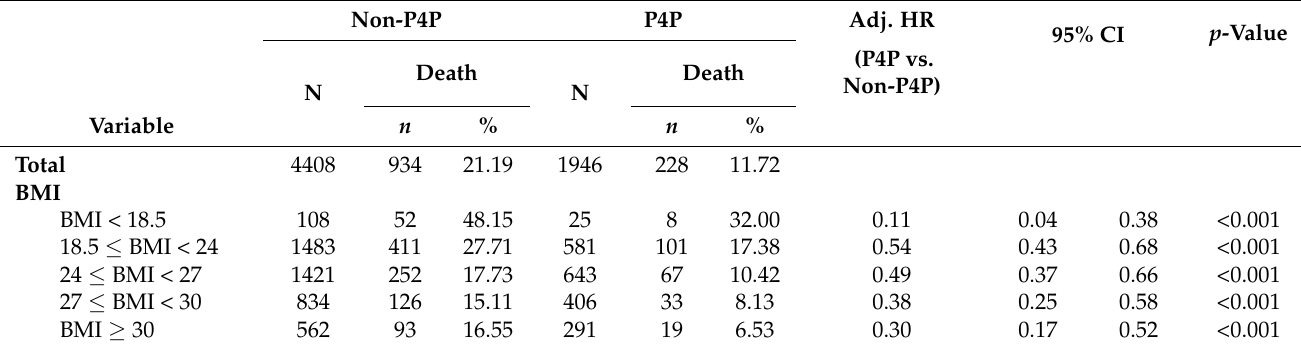
Figure 1. Comparing the effects of P4P and non-P4P on the death risk in patients with different BMIs via Cox proportional hazard model (after controlling for sex, age, education level, marital status, urbanization of residence area, monthly salary, CCI, DCSI, smoking, drinking, weekly energy expenditure through exercise, and primary healthcare organizations). Table 5. Comparing the effects of P4P on death risk in patients with diabetes with different BMIs by stratified